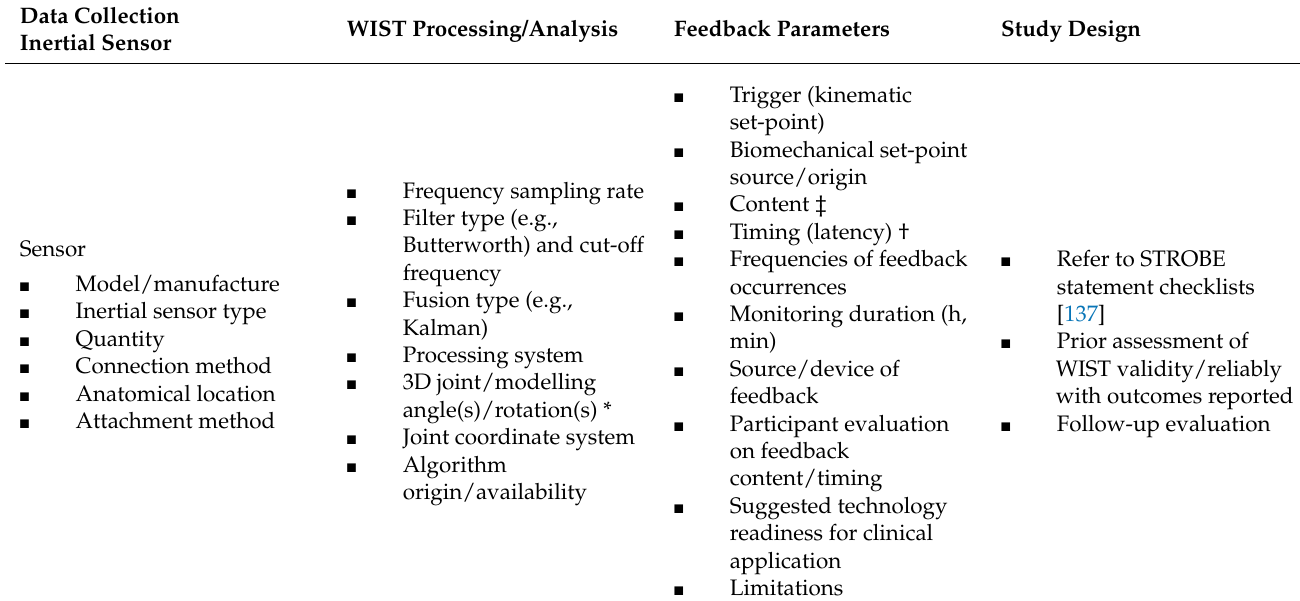
Figure 2. Overview of evaluated evidence for the effects of feedback from wearable inertial sensor technology on upper body posture and movement behaviour during workplace-related tasks. Table 10. Technology and Design